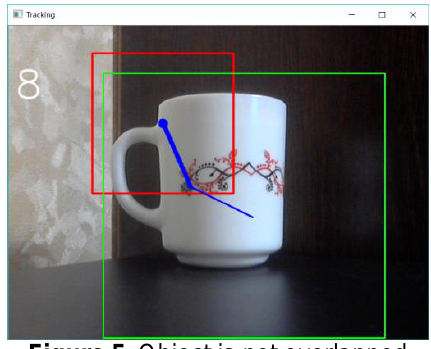
Figure 5. Object is not